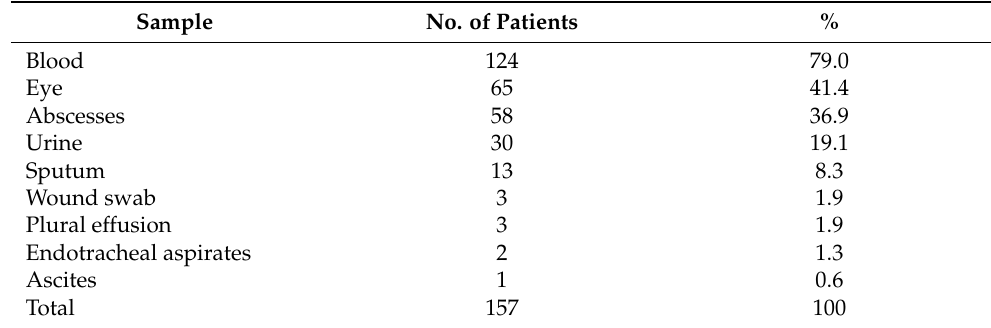
Table 2. Distribution of Klebsiella pneumoniae isolated from different